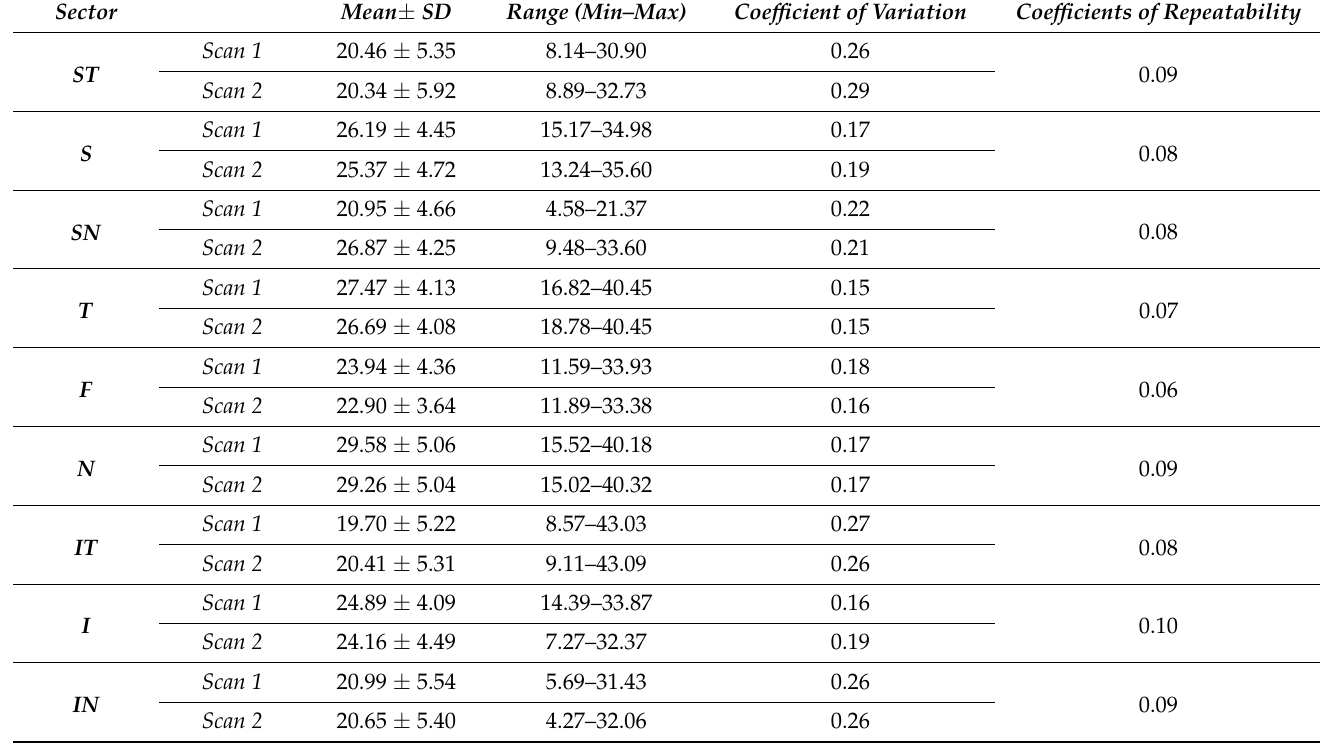
Table 5. DCP vessel density